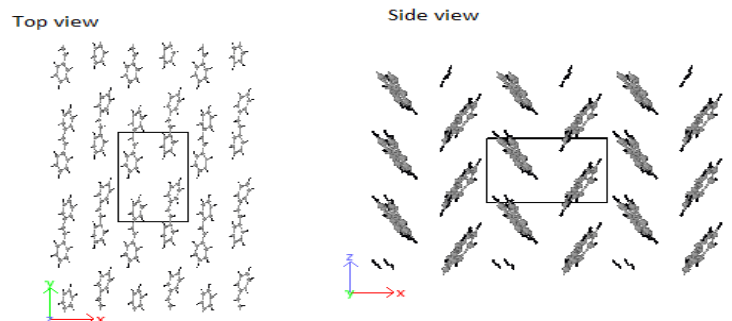
Figure 11. HB-structure of stilbene at a = ∆ x = 8.07 Å and b = ∆ z = 6.05 Figure 11. HB-structure of stilbene at 𝑎 = Δ𝑥 = 8.07 Å and 𝑏 = Δ𝑧 = 6.05 Å . Figure 11. HB-structure of stilbene at 𝑎 = Δ𝑥 = 8.07 Å and 𝑏 = Δ𝑧 = 6.05 Å .